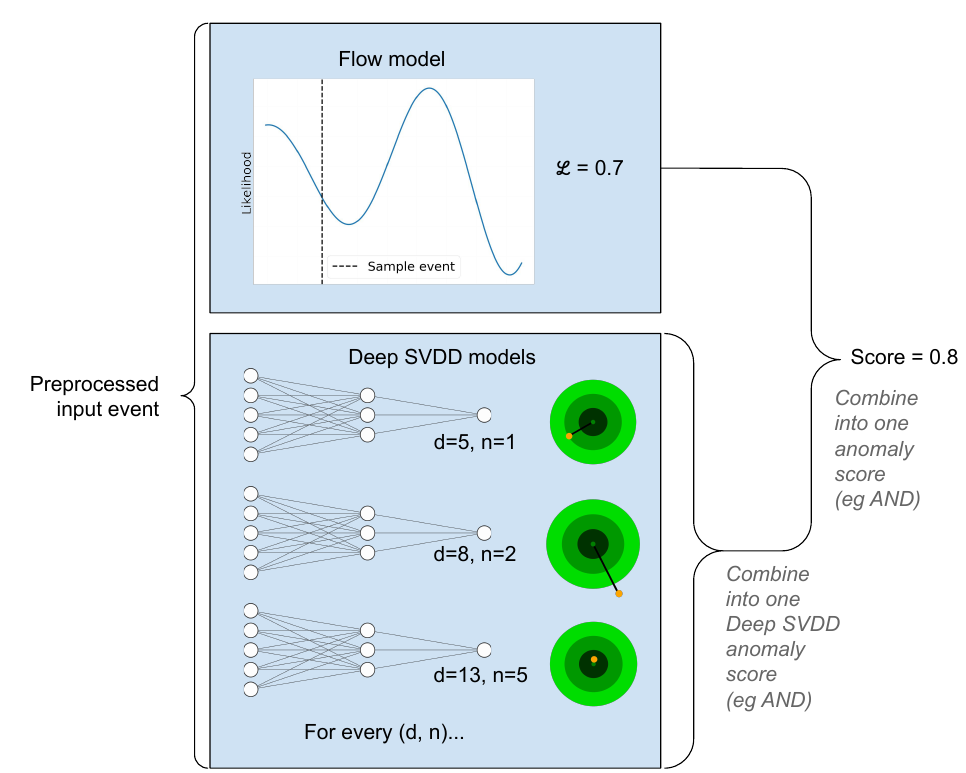
Figure 3: Diagram of the algorithm with example numbers. First, the event is passed through the flow model and Deep SVDD models. From the Deep SVDD models one anomaly score is derived and this score is then combined with the flow model score to obtain a final anomaly score. The combination algorithms are shown in table 4 and all possible values for d and n in table